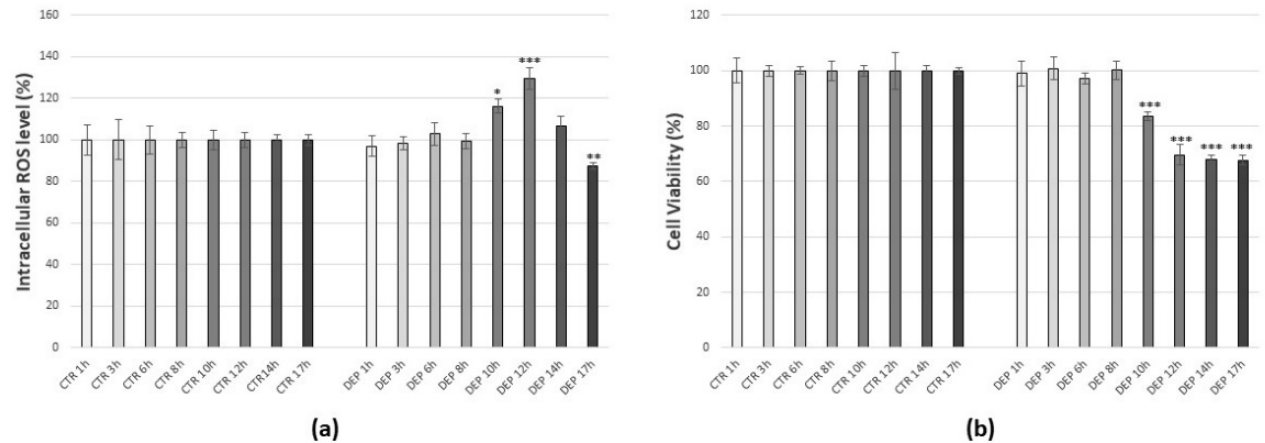
Figure 3. Time dependent effects of DEPs in C6 glioma cells. ( a ) Intracellular DCF fluorescence intensity of cells treated with 25 µ g/mL DEPs for increasing times. ( b ) Cell viability of cells treated with 25 µ g/mL DEPs for increasing times. Values represent Mean ± SE obtained from three independent experiments. * p < 0.05 versus control, ** p < 0.01 versus control, *** p ˂ 0.001 versus control.